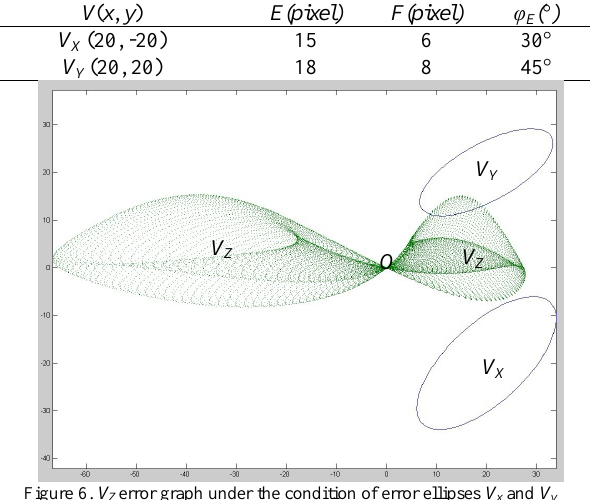
Table 1. The error ellipse parameters of V X and V Y V ( x , y )